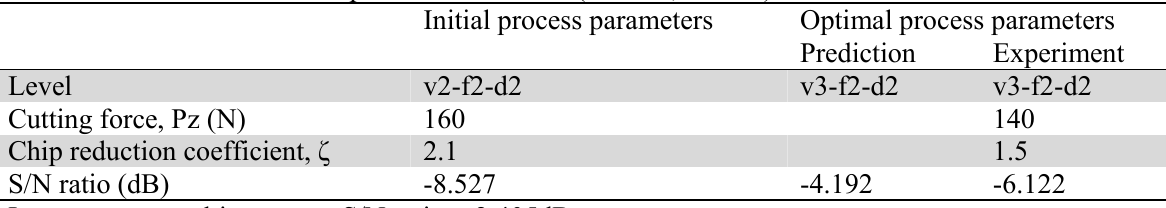
Results of the confirmation experiment for case-2 (w 1 = 3, w2 = 7) Initial process parameters